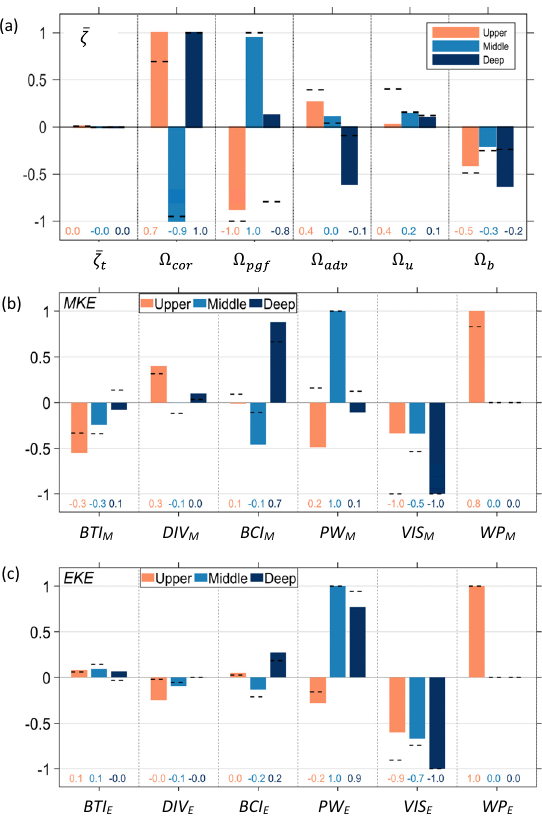
Fig. 4 Vorticity and MKE equations balances. The 20-year mean of terms in Eq. (5) (upper panel), Eq. (10) (middle panel), and Eq. (11) (lower panel) in the upper (orange), middle (blue), and deep (black) layer of hotspots, respectively. In a , (cid:1) ζ t is acceleration, Ω cor is divergence or vortex stretching, Ω Ω pgf is the bottom pressure torque, adv is horizontal advection and tilting, Ω Ω fi c layer, u and b are upper and bottom stress curl in each speci respectively. c is similar to b , except for EKE . In b , c , BTI (M,E) are barotropic instability, DIV (M,E) are divergence of mean and eddy energy fl ux, BCI (M,E) are baroclinic instability due to mean or eddy buoyancy fl ux, PW (M,E) are horizontal mean and eddy pressure work, VIS (M,E) are turbulent viscosity dissipation and WP (M,E) are wind power input for MKE and EKE , respectively. Terms are normalized in hotspots. Black dashed lines and the corresponding numbers in each panel represent the corresponding normalized values over the entire SCS